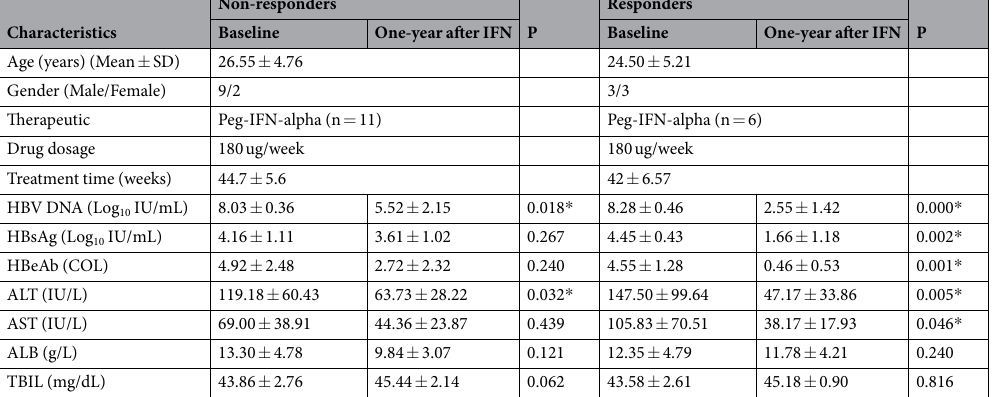
Table 1. Difference of Hepatitis B patients serum parameters between responders and non-responders at baseline or one-year after PEG-IFN therapy. * Represent statistical